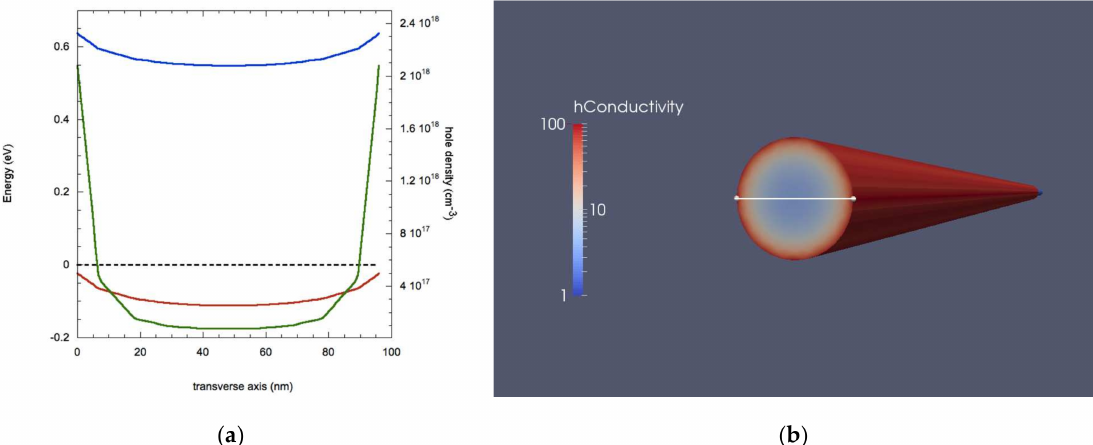
Figure 6. ( a ) Values for energy bands (blue: bottom of conduction band, red: peak of valence band), Fermi level (dashed black line) and carrier density (green line) along the transverse axis for a Ge NW with additional n surface charges. ( b ) transverse section of a 3D plot of